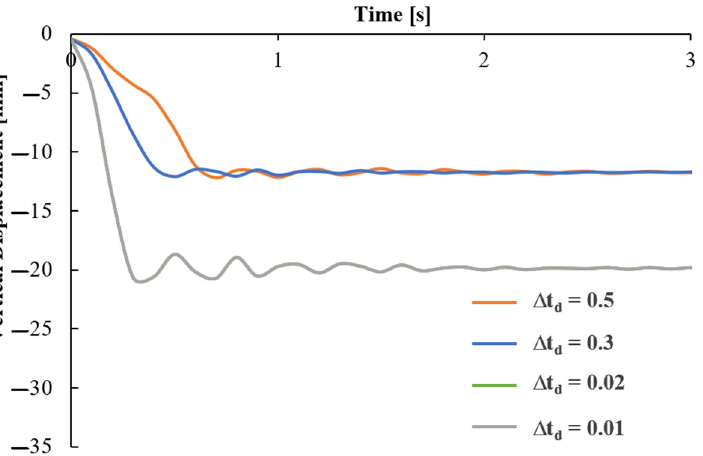
Figure A3. Displacement of the node at the top of column 3: effect of variation of ∆ t d (removal time of the column). ∆ t d values are expressed in seconds.